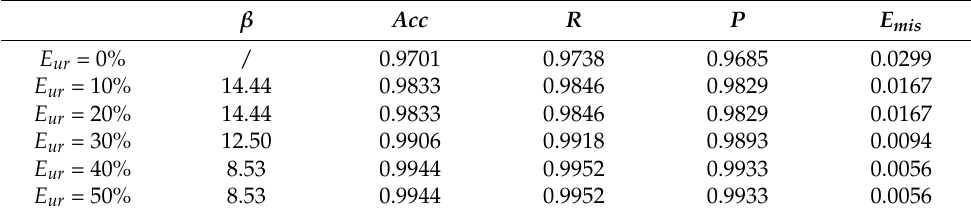
Table 7. Performance of three-way decision on the Wine dataset.